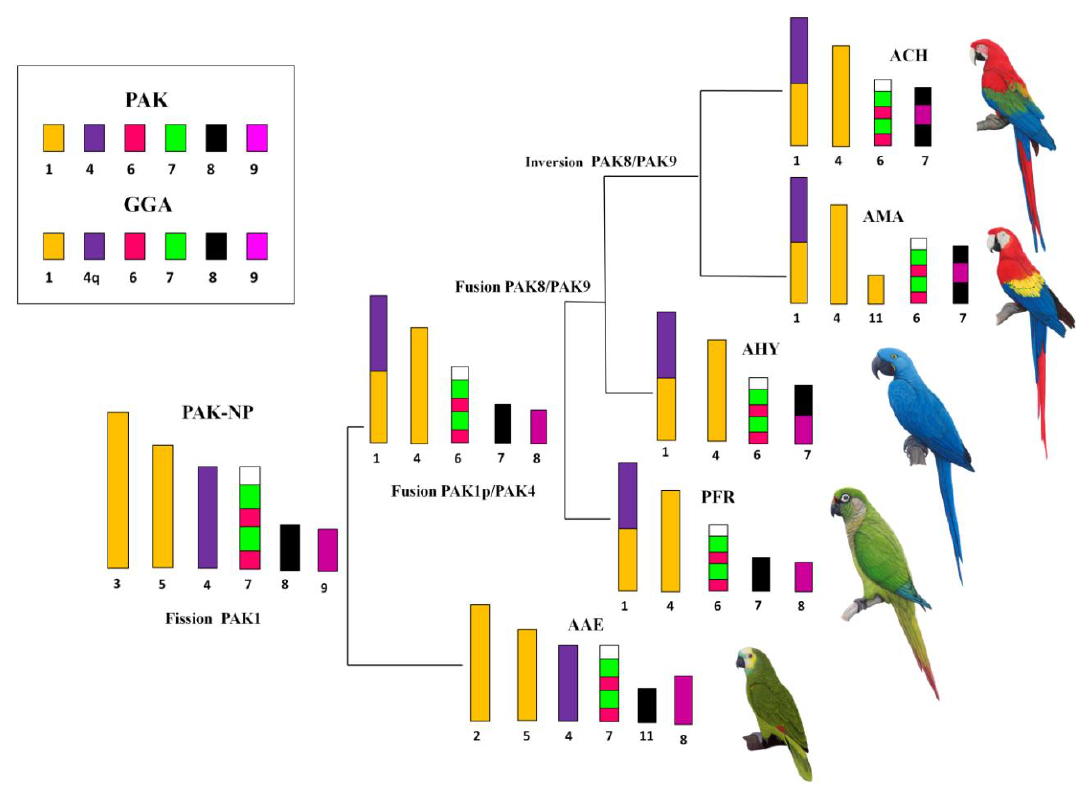
Figure 8. Phylogenetic analysis based on rearrangements involving PAK1, PAK4, PAK6, PAK7, PAK8, and PAK9 in Neotropical Psittacidae, according to results obtained by FISH with probes of G . gallus and L . albicollis (legend: PAK, putative ancestral avian karyotype; PAK-NP, putative ancestral karyotype of Neotropical Psittacidae; AMA, Ara macao ; ACH, Ara chloropterus ; AHY, Anodorhynchus hyacinthinus .